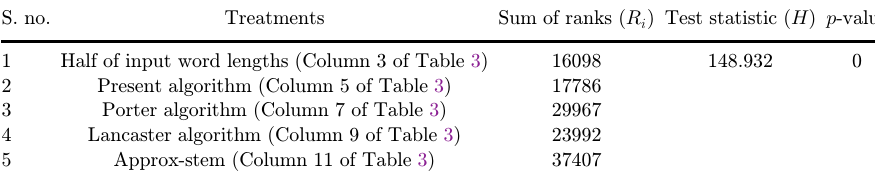
Table A.1. Summary of Kruskal – Wallis